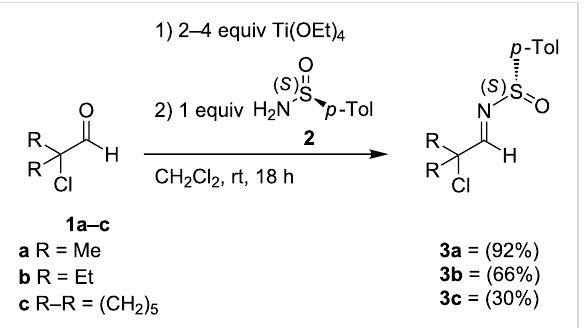
Scheme 1: Synthesis of chiral α -chloro- N - p -toluenesulfinylaldimines 3 .